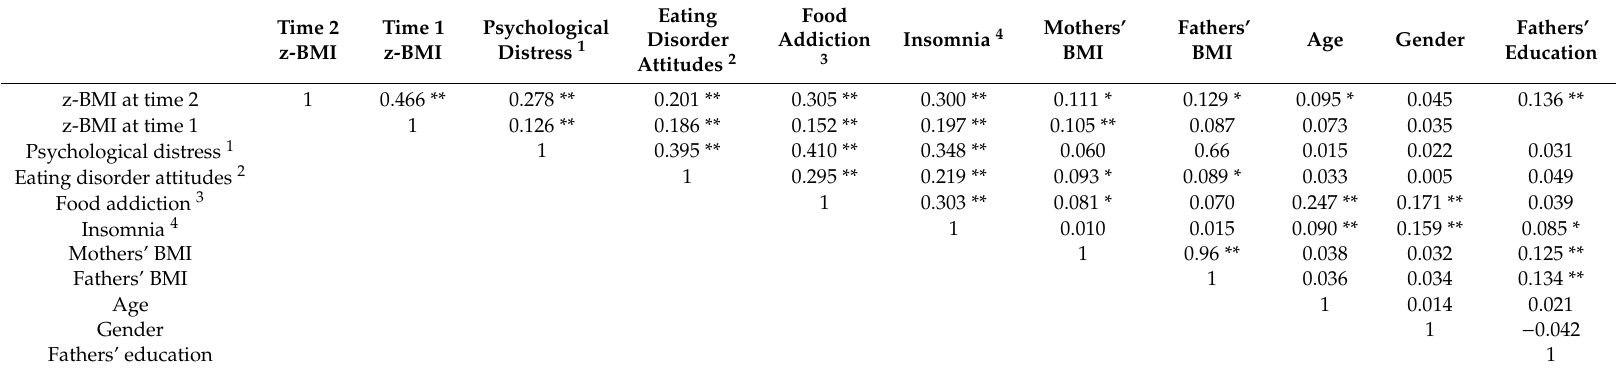
Table 2. Pearson (cid:48) s correlation matrix of the variables of interest.